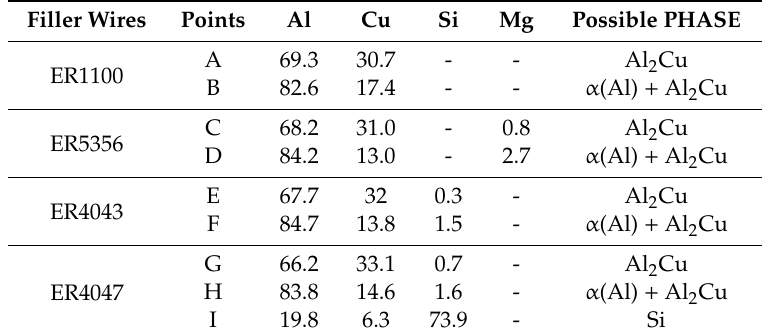
Table 6. EDS results in selected zone from Figure 5 /at%.